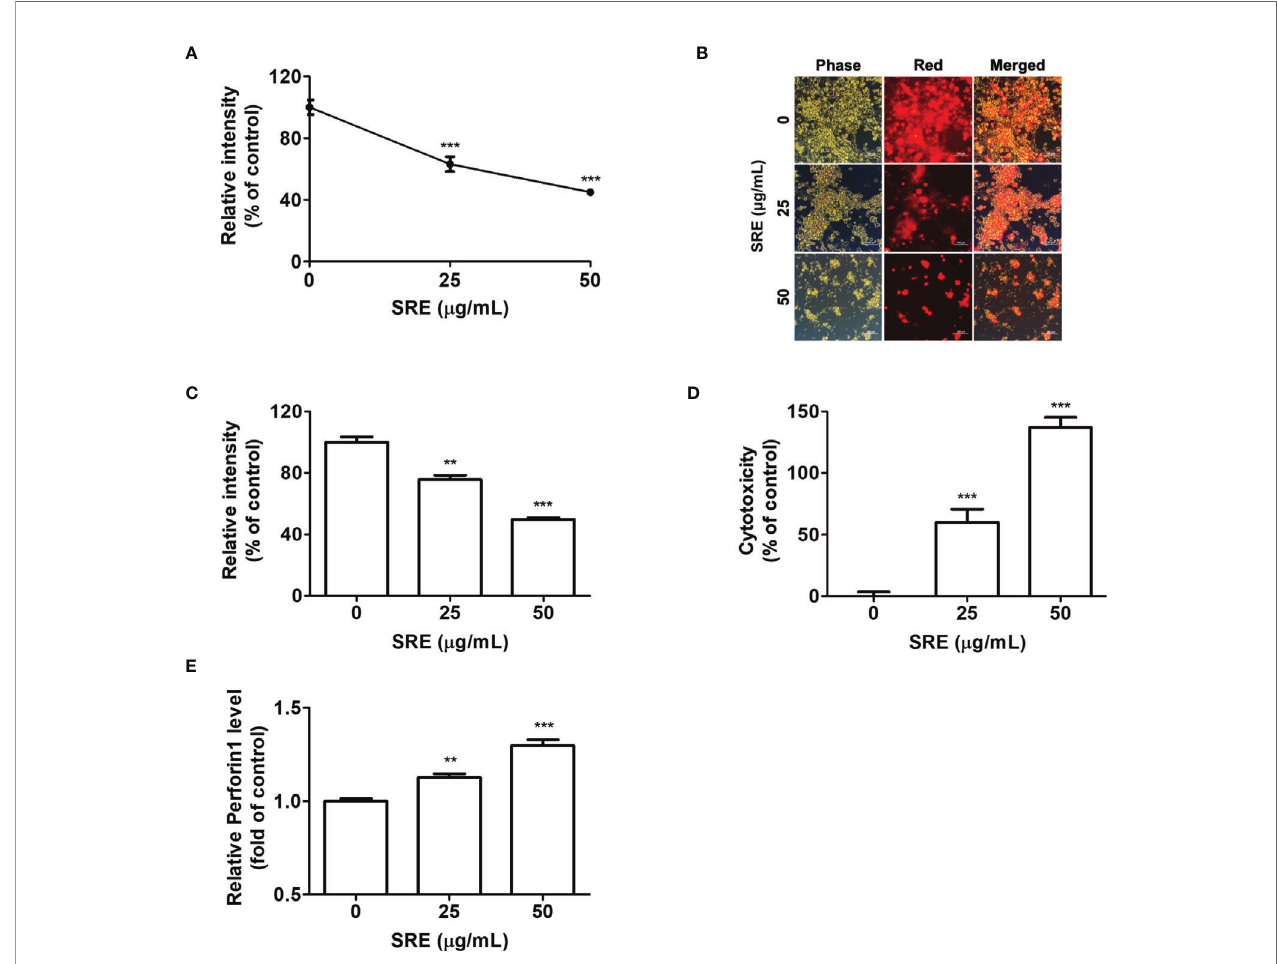
FIGURE 4 | SRE elevated the activation of hPD-1 + CD8 + T cells and the CD8 + T cell-mediated killing effect on hPD-L1 MC38 cancer. (A) Cocultured hPD-L1 MC38 cell viability, tested by crystal violet staining. Cocultured hPD-L1 MC38 cells detected with fl uorescence microscopy (× 200) (B) and determined by fl uorescent- activated cell sorting analysis (C) . (D) LDH released from damaged cells; (E) Relative perforin 1 (PRF1) level, determined with use of the mouse PRF1 ELISA kit. Data are presented as the mean ± SD. ** p < 0.01 and *** p < 0.001 compared to the vehicle